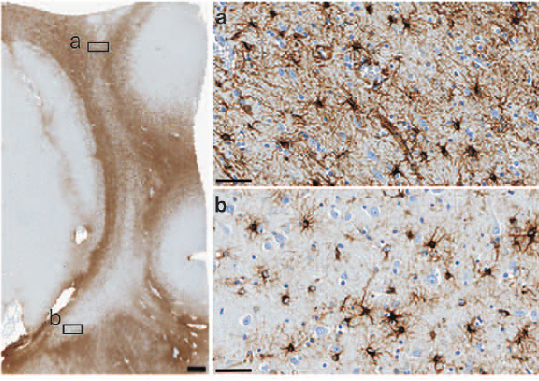
Figure 5. GFAP-ir distribution in the claustrum and adjacent structures. (A) Low magnification image. (a, b) Higher magnification images of A correspond to the dorsal claustrum (a), the ventral claustrum (b). Scale bar =1 mm (A), 50 m m (a,